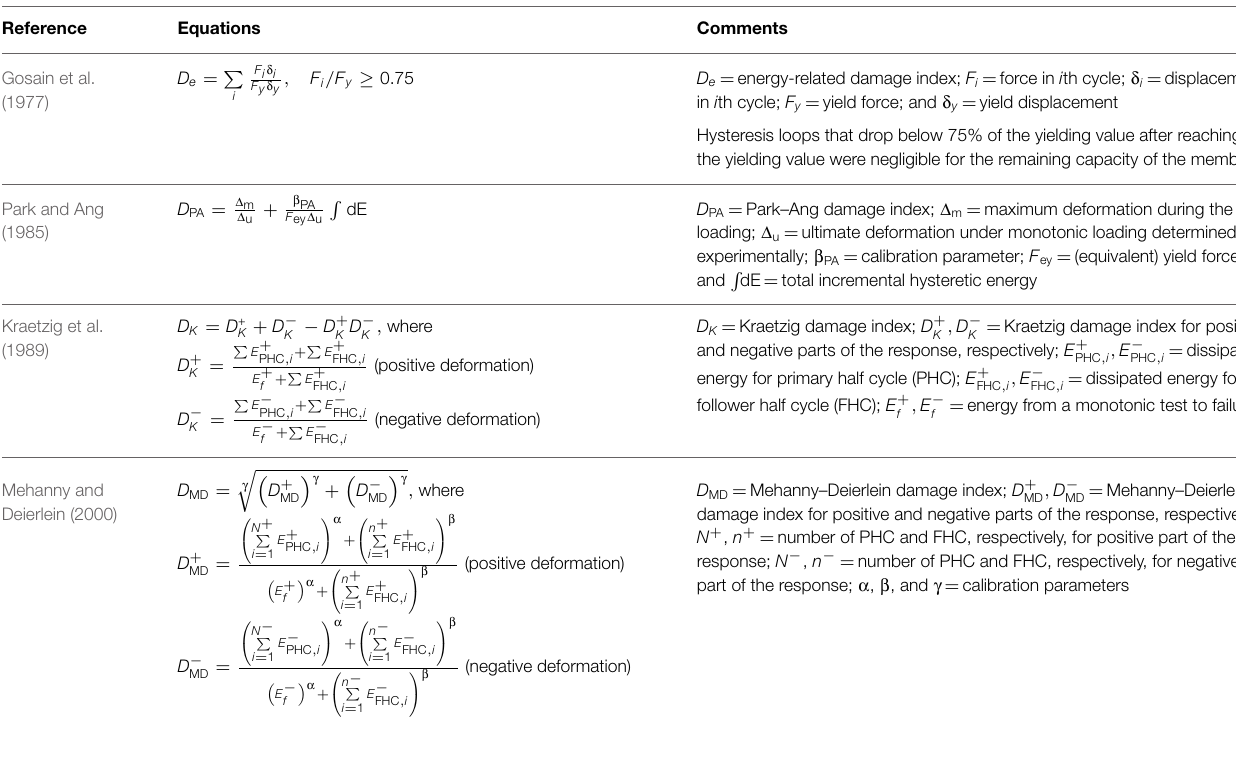
TABLE 1 | Energy-based and combined damage indices